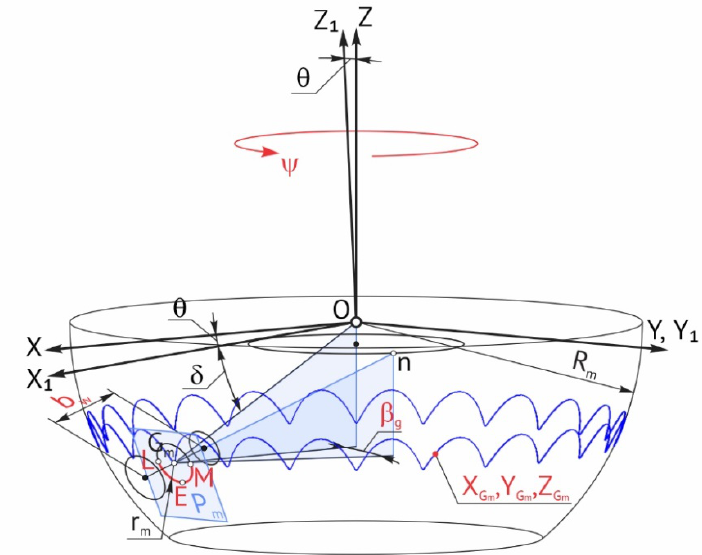
Figure 1. Description of the spatial positioning of the inclined tooth in the gear D, A β